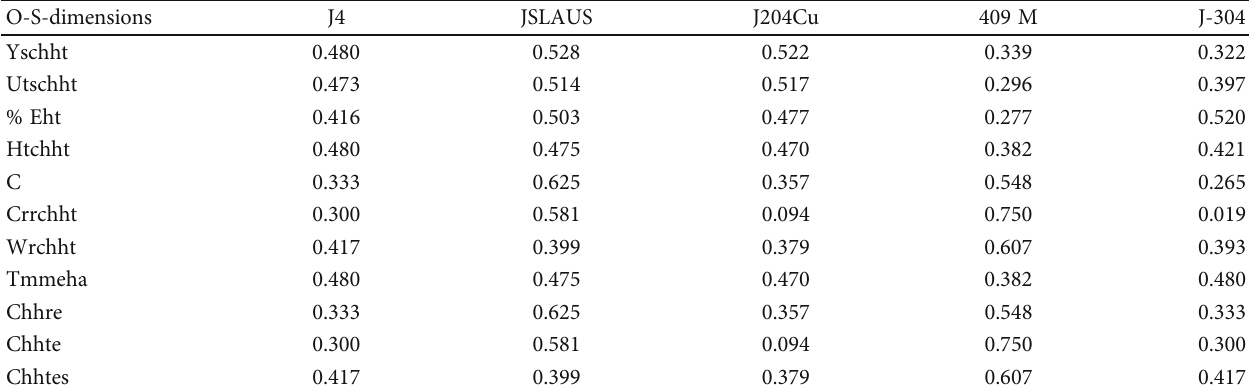
Table 7: Computed normalized values of TEHES-O-S-tube material dimensions for assessing